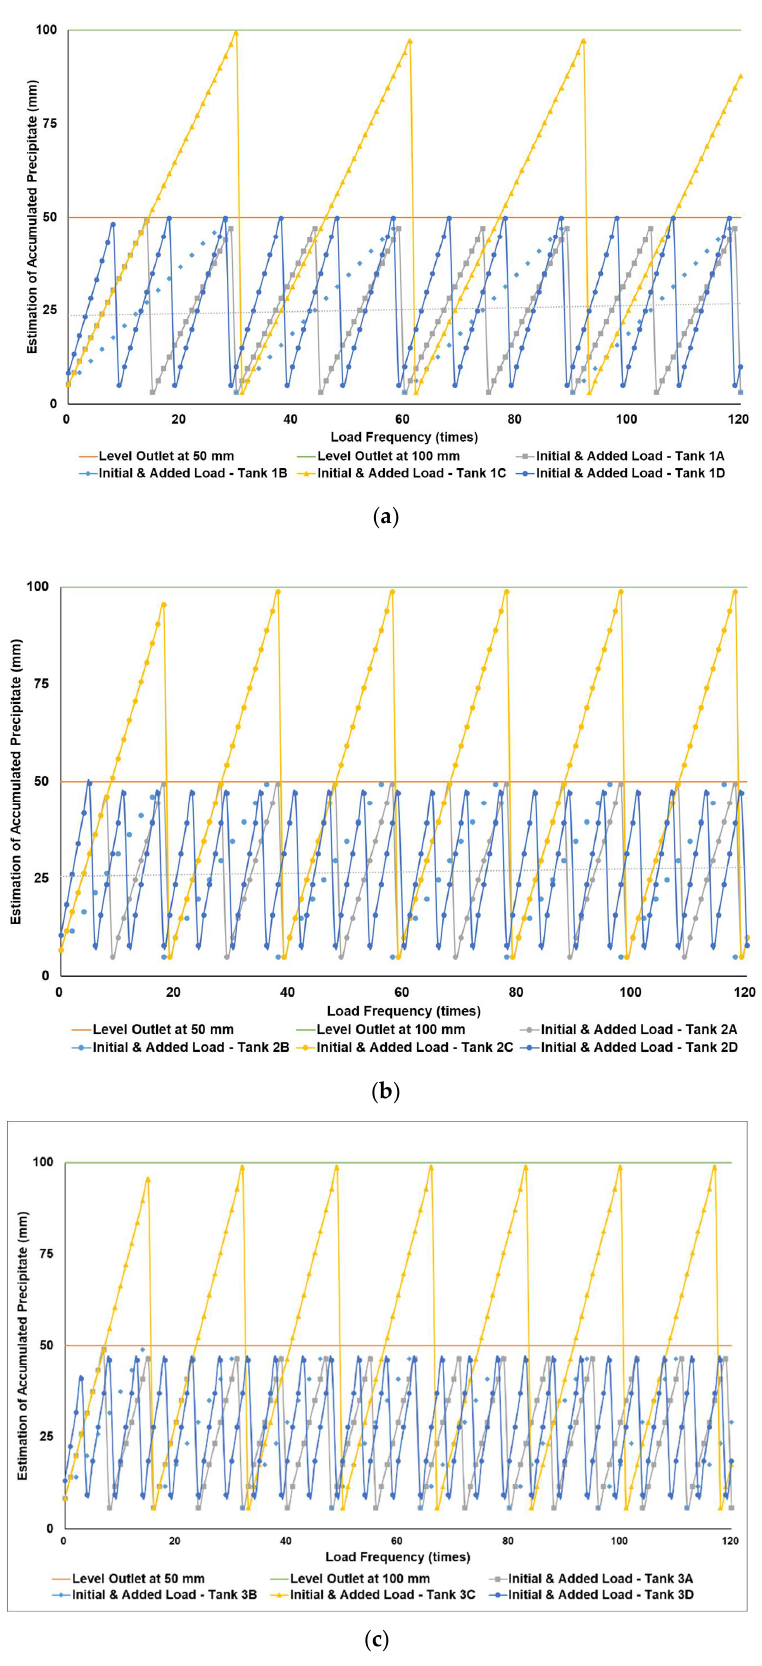
Figure 5. Schedule simulation for sludge removal from the storage tank of B20 fuel from the market. The tank volume is ( a ) 50, ( b ) 100, and ( c ) 200 m 3 . Figures 3–5 show a very clear difference in the accumulation of B20 storage tanks containing different MGs. The horizontal lines at the 50- and 100-mm points indicate the outlet levels. After reaching the two outlet setting levels, the loading curve returns to its lowest point due to sludge removal. The cycle of accumulation of precipitation will repeat itself.